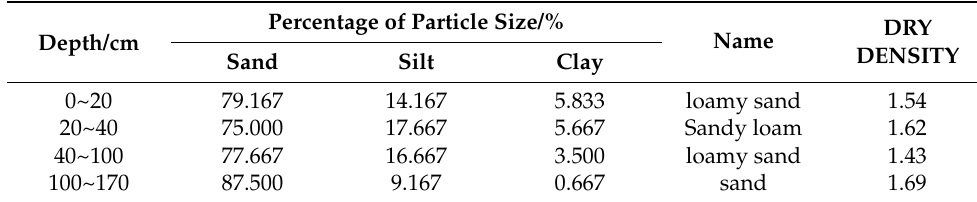
Table 2. Soil physical properties of the cotton